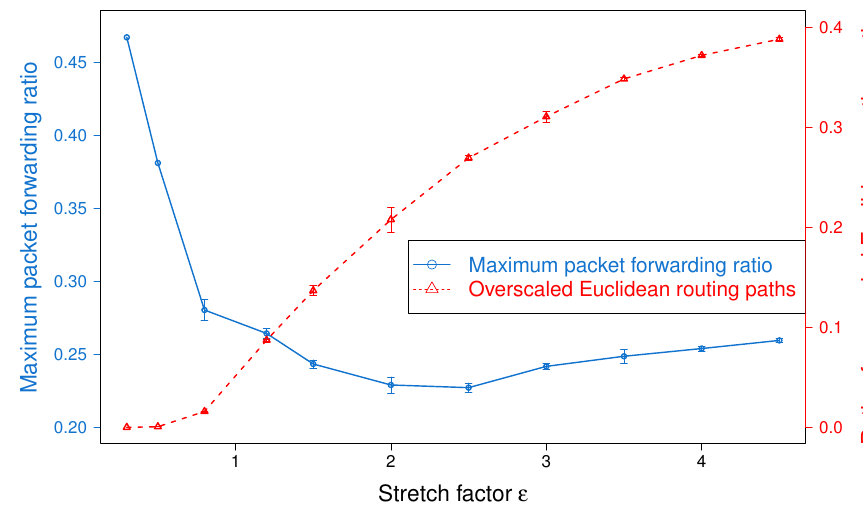
Figure 11. Impact of (cid:101) on load balance. The blue lines represent the maximum packet forwarding ratio of sensor nodes, the red lines represent the percentage of Euclidean routing paths that exceed the network